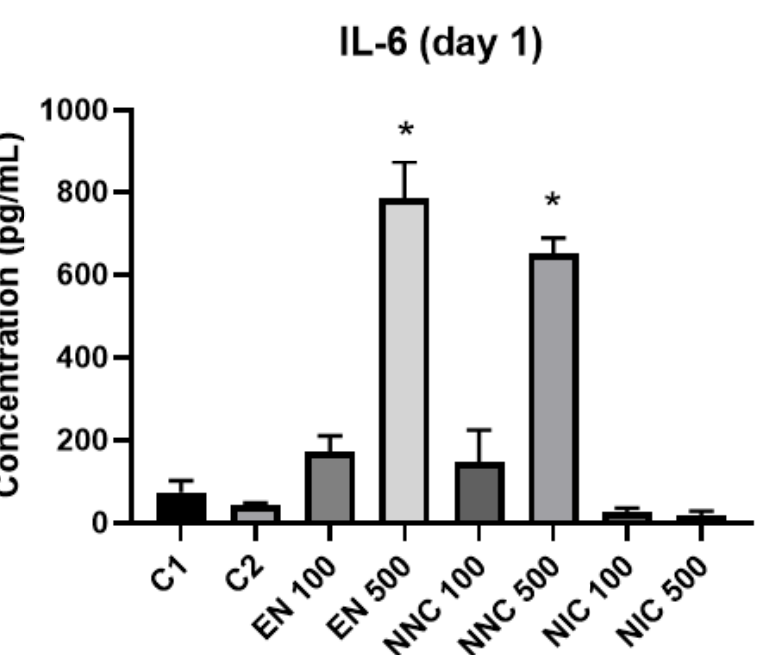
Figure 10. IL-6 detection one day after treatment with nanocapsules. C1 = control cells with